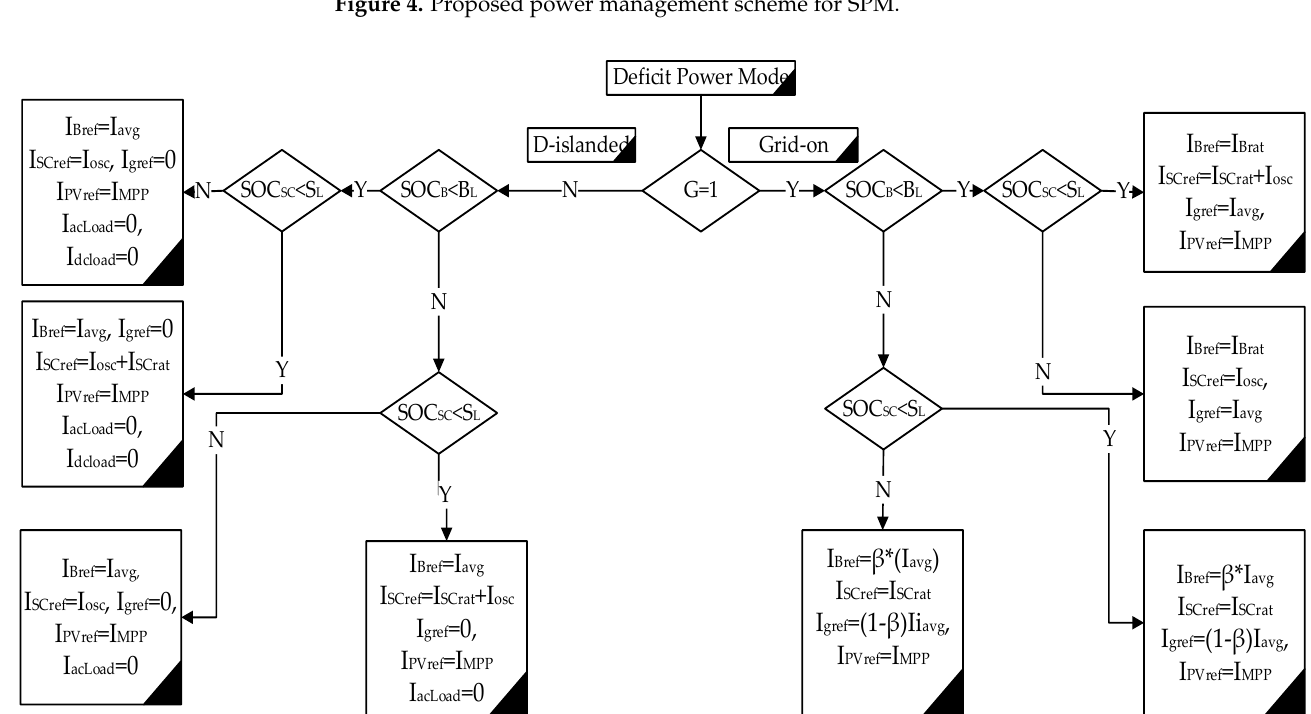
Figure 5. Proposed power management scheme for DPM.